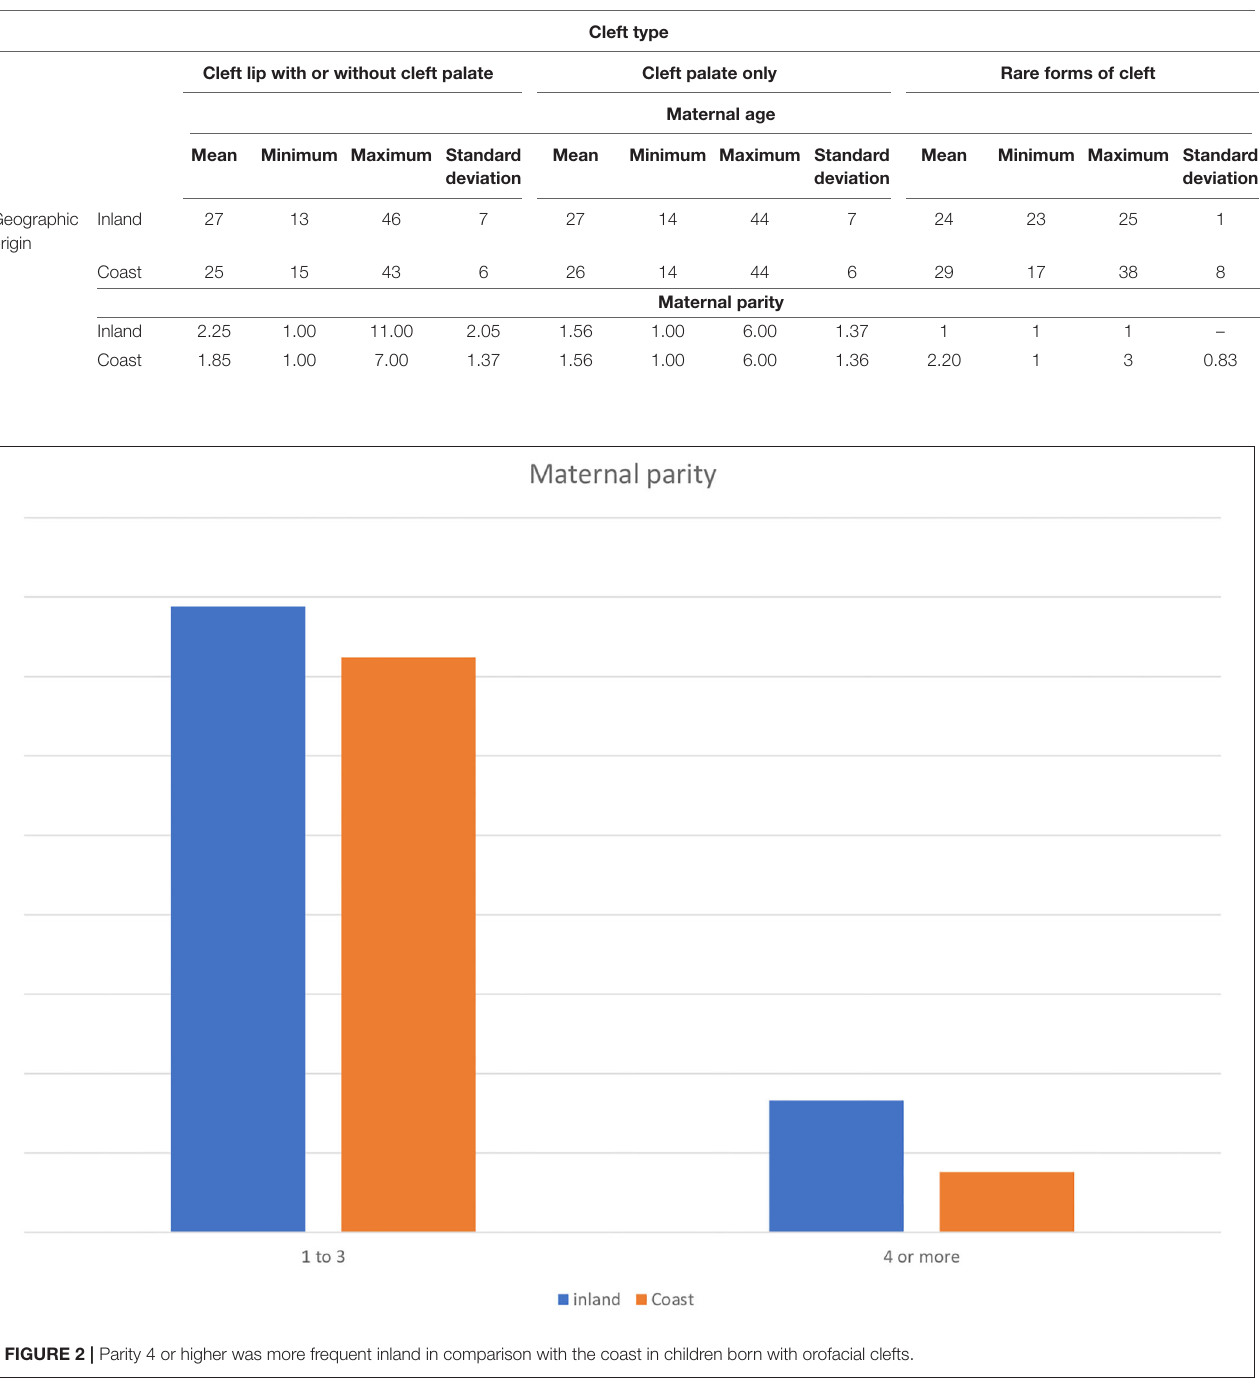
TABLE 2 | Distribution of maternal age, maternal parity, according to geographic origin, and cleft